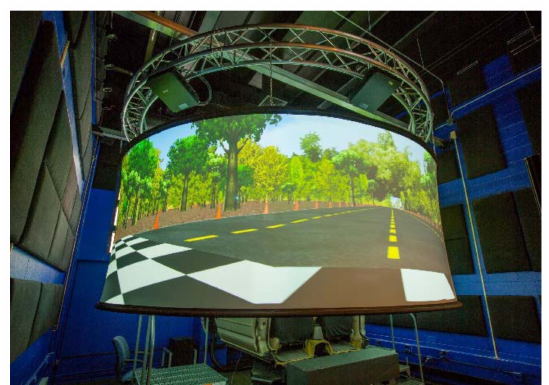
Figure 3. Simulator (display system).